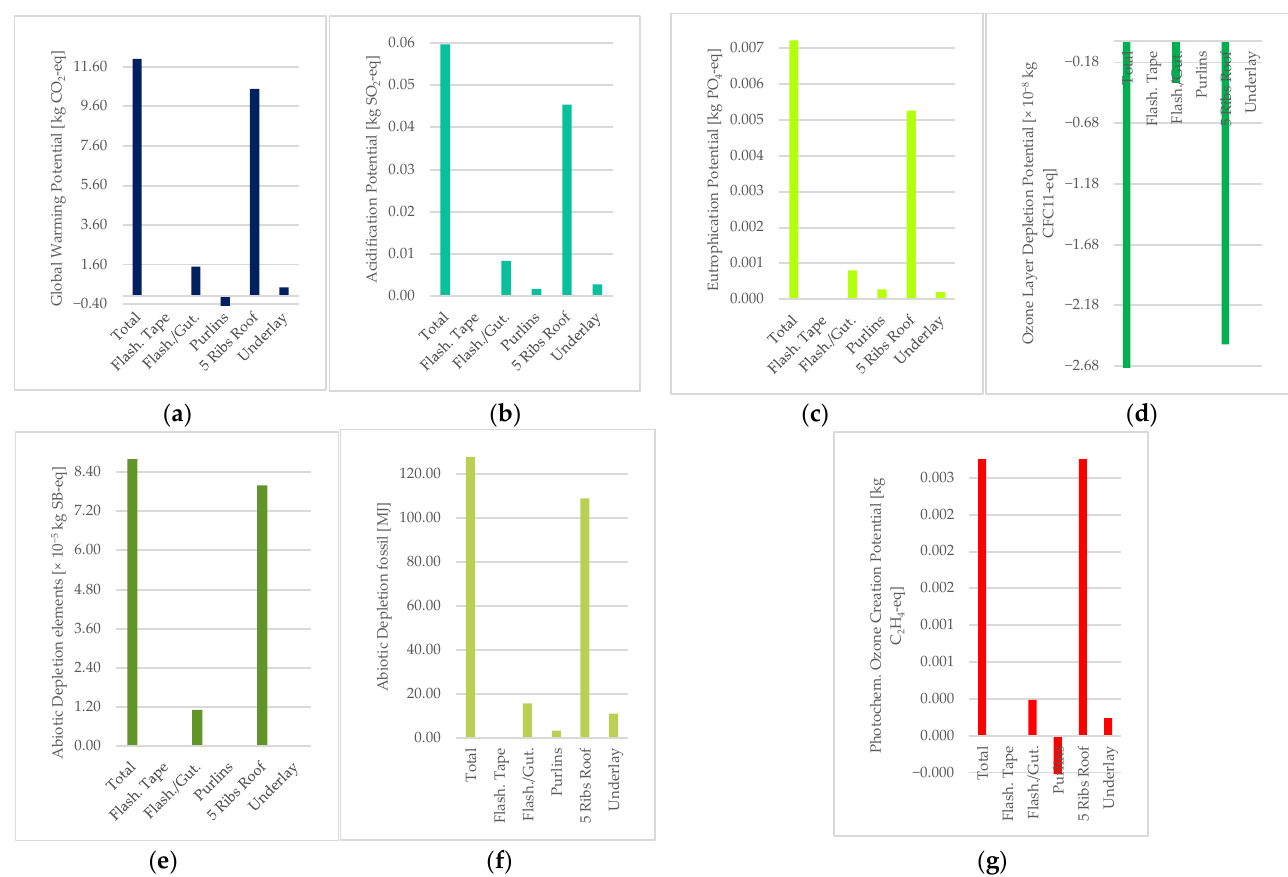
Figure 8. Outputs from GaBi showing the environmental impacts of steel roofing including ancillary items for 1 m 2 of the case study house: ( a ) GWP; ( b ) AP; ( c ) EP; ( d ) ODP; ( e ) ADP elements; ( f ) ADP fossil; ( g ) POCP.